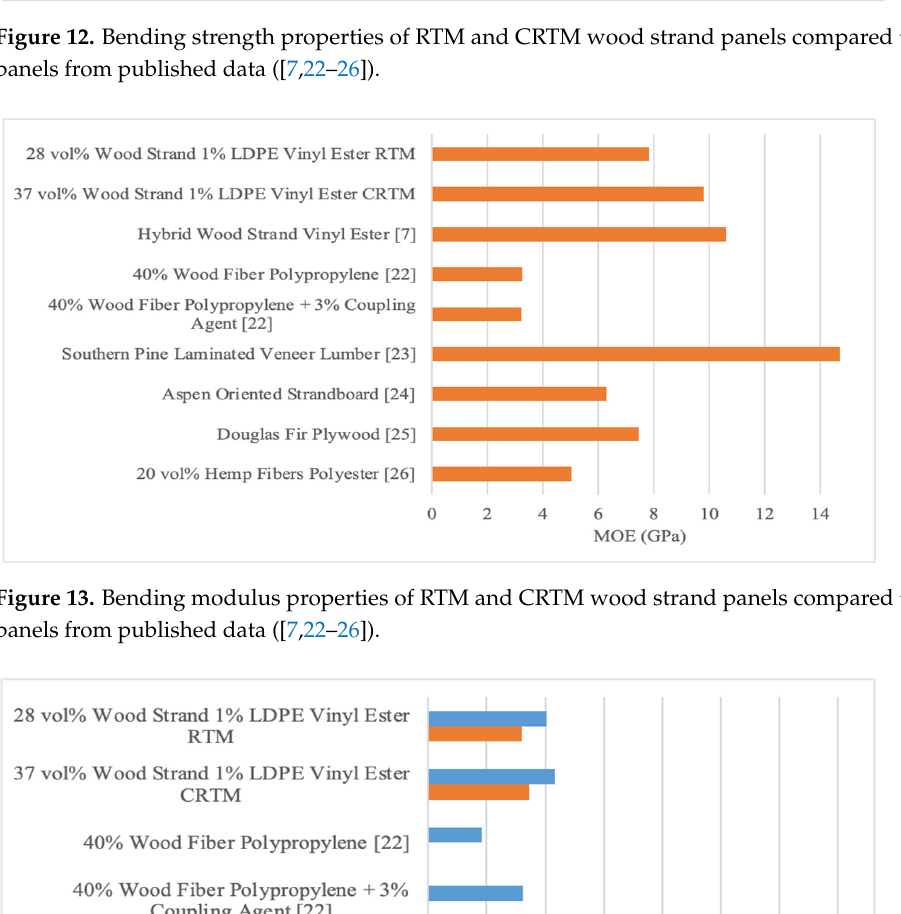
Figure 15. Moisture absorption and thickness swell behavior of RTM and CRTM wood strand panels compared to other panels from published data ([7,24,27]). 5. Conclusions A consistent and repeatable process was developed to produce low-density poly- ethylene-bound wood strand preforms for subsequent resin transfer molding of wood strand composite panels with superior performance, and with less variation compared to commercially produced wood strand composites. A volumetric interpretation of Darcy’s law was more effective in quantifying the permeability of the preforms than a one-dimensional interpretation. Compression-assisted RTM wood strand panels exhib- ited improved strength and stiffness and improved dimensional stability compared to other types of commercially available wood-based composites. Author Contributions: Conceptualization, V.Y. and B.G.; methodology, B.G.; formal analysis, B.G.; investigation, B.G.; resources, V.Y. and L.S.; data curation, V.Y.; writing—original draft prepara- tion, B.G. and V.Y.; writing—review and editing, V.Y. and L.S.; supervision, V.Y. and L.S.; project administration, V.Y.; funding acquisition, V.Y. and L.S. All authors have read and agreed to the published version of the manuscript. Funding: This work was supported by the Agriculture and Food Research Initiative grant no. 2016– 67021–24413 from the USDA National Institute of Food and Agriculture. Institutional Review Board Statement: Not applicable. Informed Consent Statement: Not applicable.